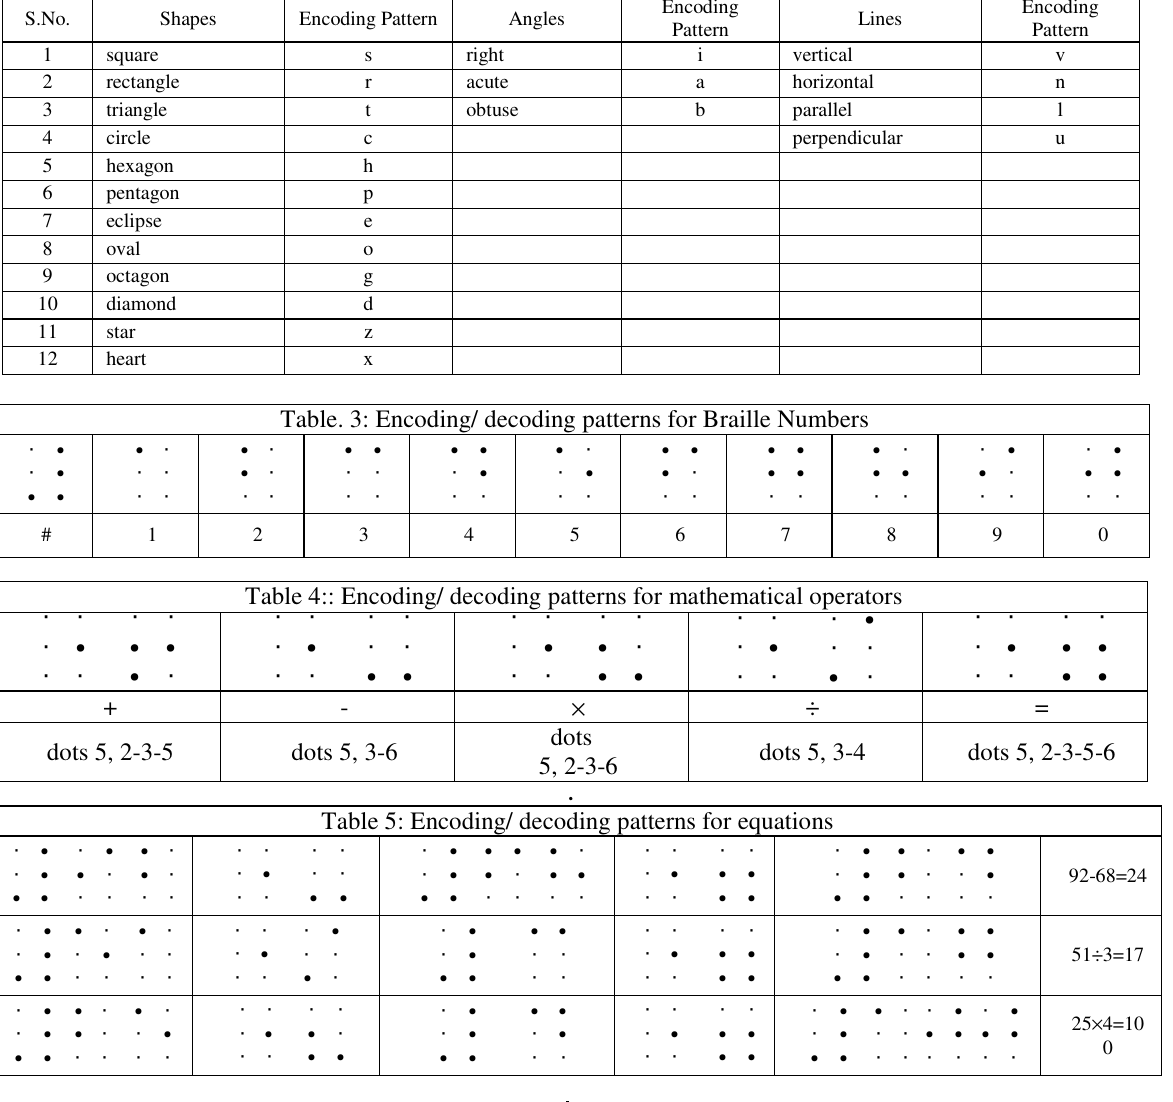
Table 2: Encoding/ decoding patterns for Module 2 in designed optical braille blocks system S.No.